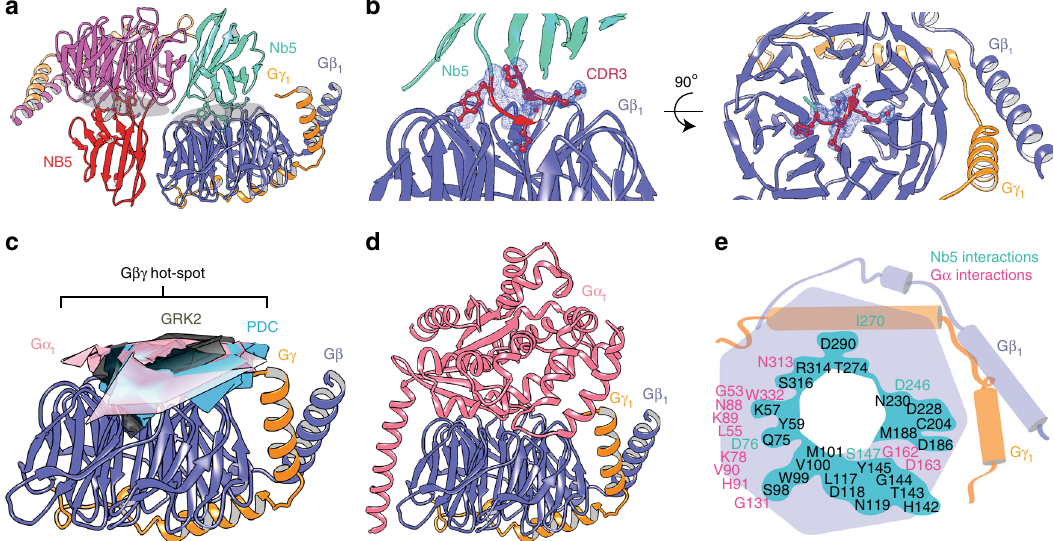
Fig. 3 Crystal structure of G β 1 γ 1 in complex with Nb5. a The asymmetric unit contains two molecules of both G β 1 γ 1 (blue and pink) and Nb5 (greencyan and red) shown in cartoon representation. Key interfaces between G β 1 γ 1 and Nb5 are denoted by grey ellipsoids. b Side and top views of the G β 1 γ 1 -Nb5 complex showing the CDR3 region (red) of Nb5 inserted into the G β 1 -propeller. The 2 |F o | - |F c | density (blue) around the CDR3 region was calculated after the fi nal re fi nement and is contoured at 1.5 σ . c G βγ hot-spot is shared by several G βγ regulatory proteins, including G α t (pink), phosducin (PDC, cyan), and G Protein-Coupled Receptor Kinase 2 (GRK2, dark grey). d Overall structure of the heterotrimeric G protein (PDB ID: 5KDO). e Overlay of the interface between the G β 1 γ 1 -Nb5 complex and heterotrimeric G protein. Schematic representation shows the extent of overlapping (in greencyan background, black residues) between the non-canonical G β 1 γ 1 -Nb5 complex interface (greencyan residues) and the interface between G β 1 γ 1 and G α t (pink